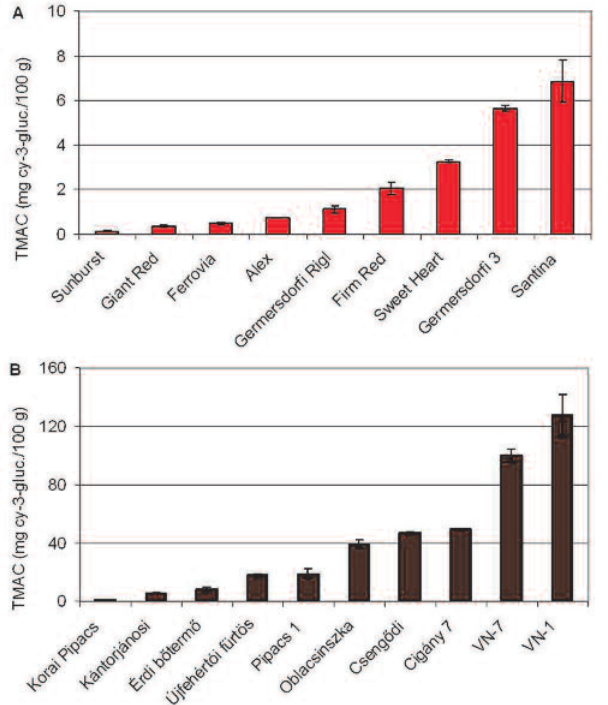
Figure 4. Total monomeric anthocyanin content of sweet (A) and sour (B) cherry